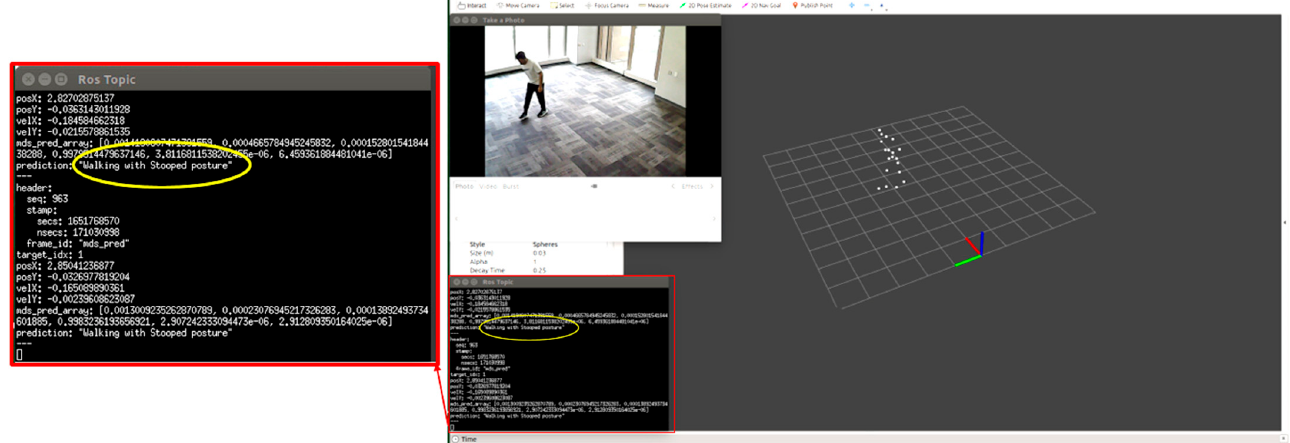
Figure 14. Subject walking with a stooped posture.